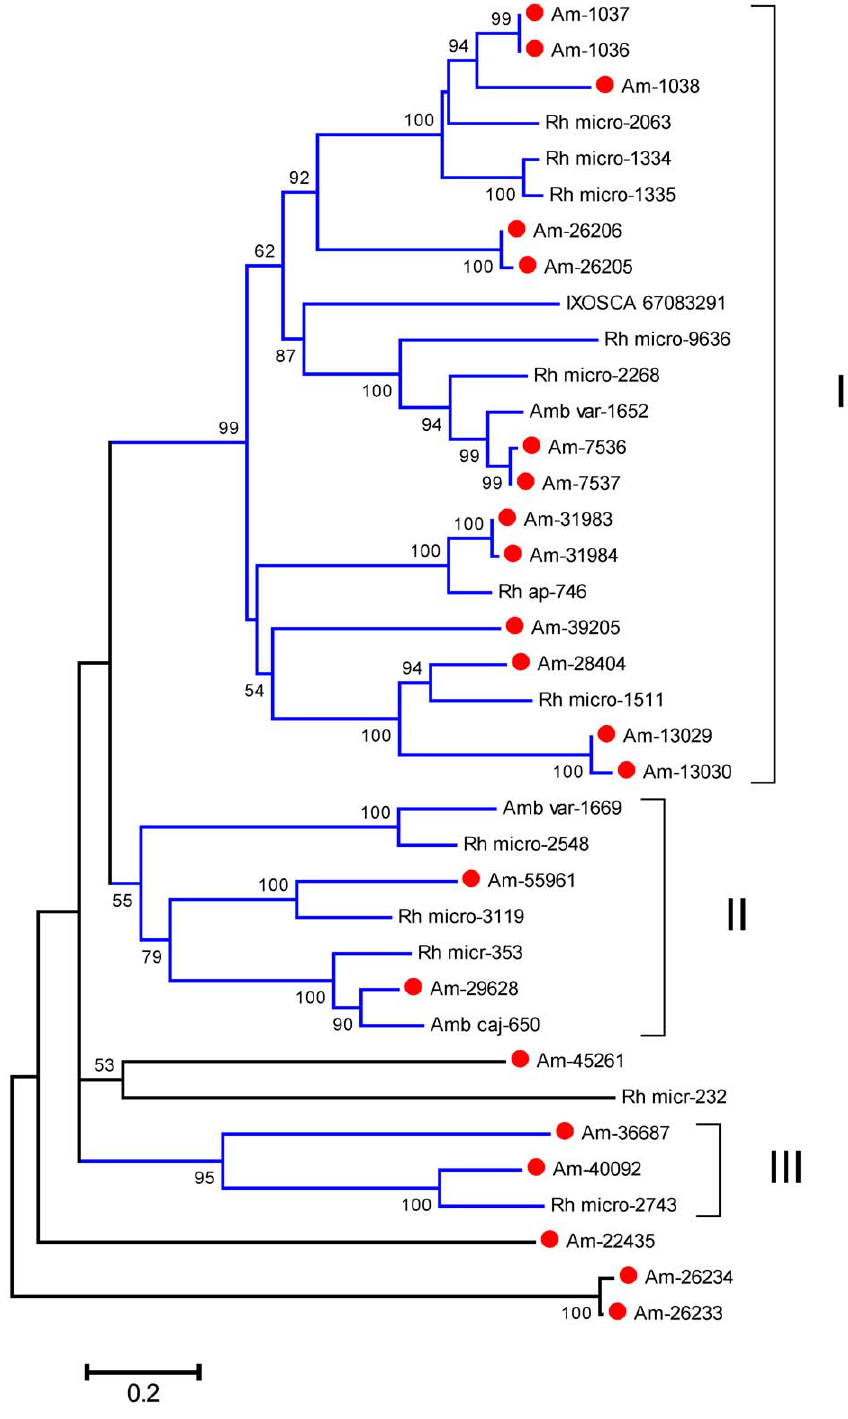
Figure 9. Phylogram of tick proteins from the novel 40-33 family. The bootstrapped phylogram (1,000 iterations) was obtained from the alignment of deducted Amblyomma maculatum proteins with homologs deducted from DBEST sequences described in a previous publication [2]. The Am. maculatum protein names start with Am- and are recognized by a red circle marker; the Ixodes scapularis protein is named IXOSCA followed by the first three letters of the species name followed by their NCBI gi| accession number. The number at the nodes indicates the bootstrap support above 50%, and the bar at the bottom indicates 20% amino acid divergence. Clades are indicated with Roman numerals.